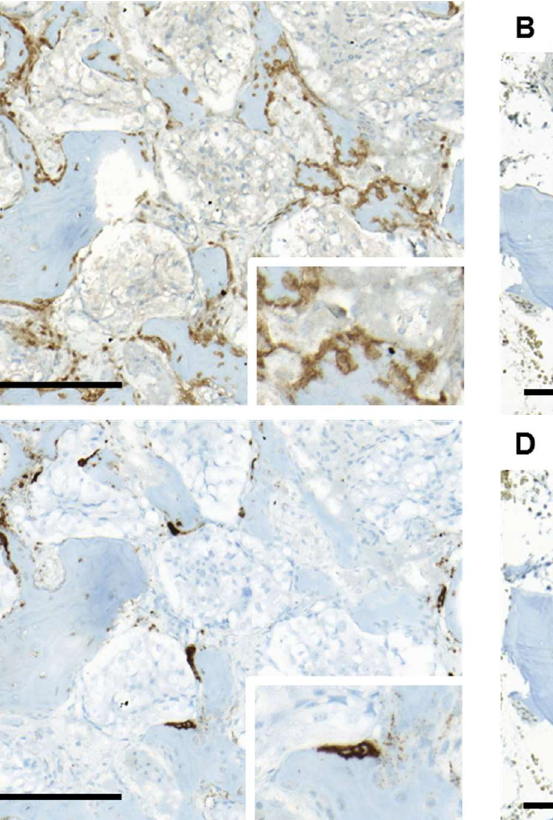
Figure 2. Percentage of bone surface lined by tartrate-resistant acid phosphatase (TRAP)-positive and runt-related transcription factor 2 (RUNX2)-positive cells, respectively. Each bar represents TRAP-positive bone surface in one patient sample and the corresponding dot represent the RUNX2-positive surface in the same patient. Castration-resistant prostate cancer patients are represented by grey bars and treatment-naïve patients by black bars. Patients who had undergone chemotherapy are denoted by asterisks.